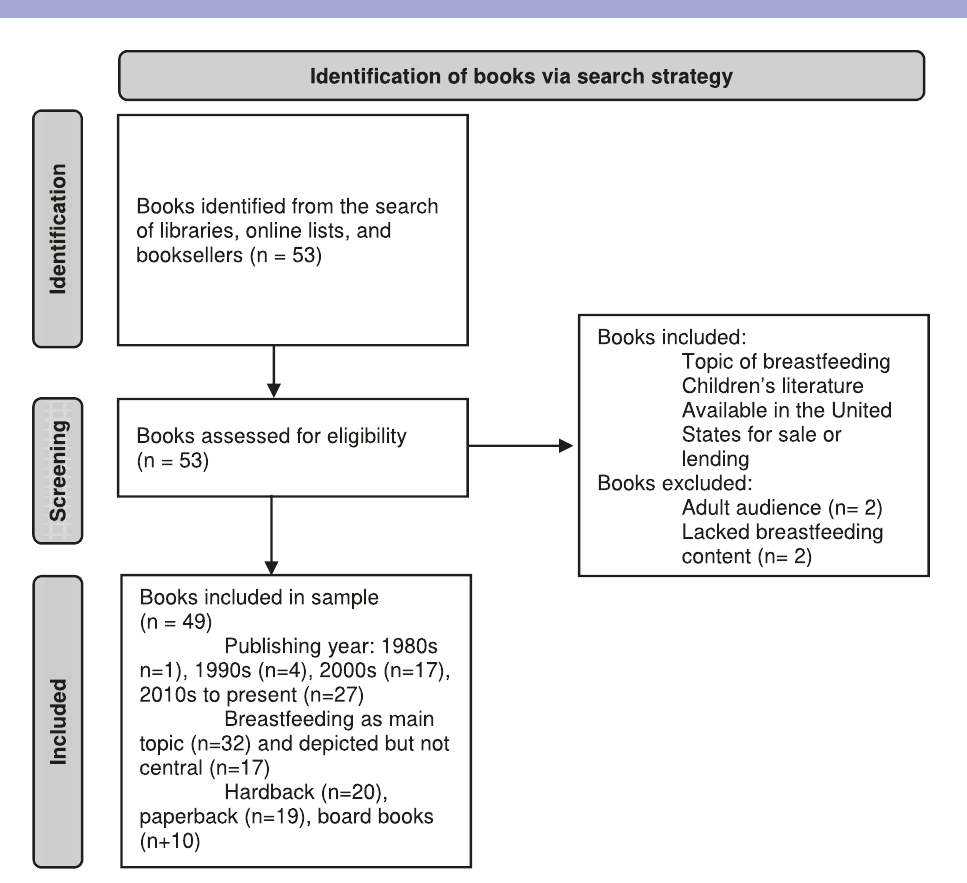
Table 2 Search strategy.